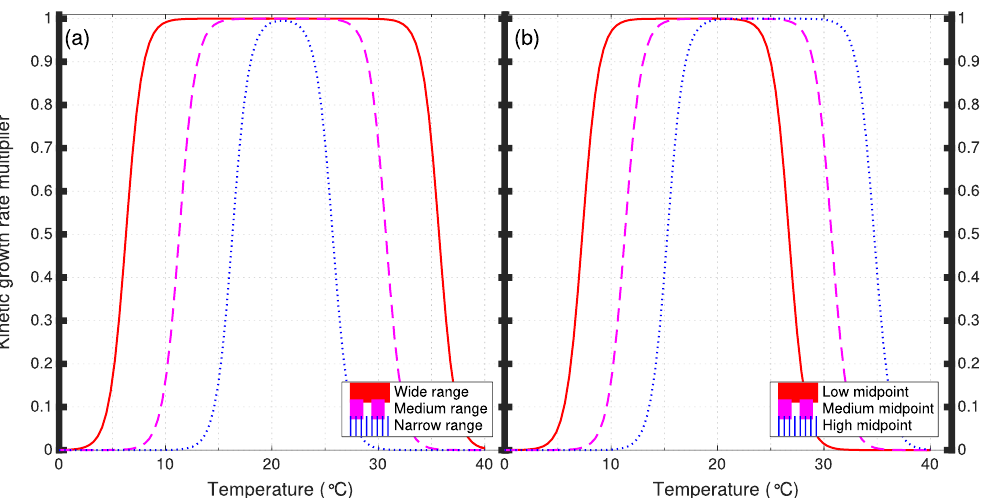
Figure 2. Example kinetic growth rate multiplier curves for tested algal growth temperature levels. Panel (a) shows the effect of varying the width of the function while maintaining a constant temperature optimum. Panel (b) shows the effect of varying the temperature optimum while maintaining the width of the function.